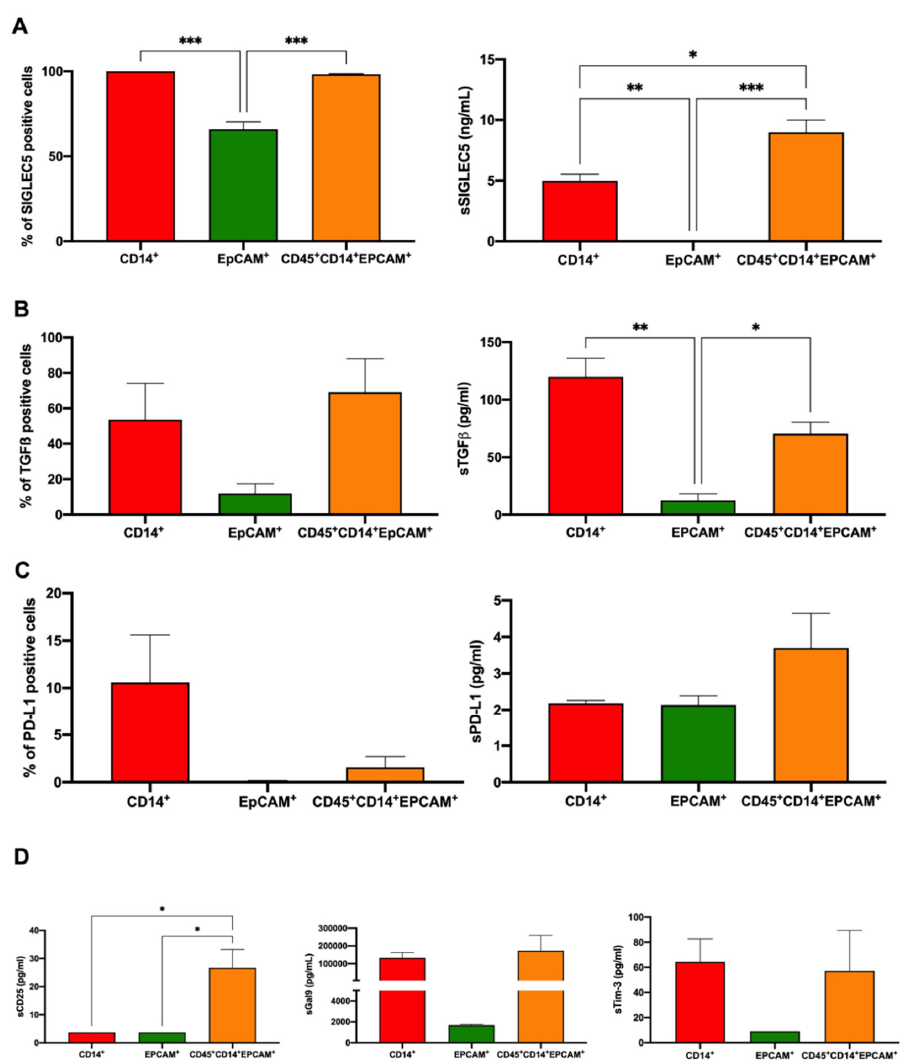
Figure 5. Characterisation of IC expression on THCs after co-culture. Left panels: expression of ( A ) SIGLEC5; ( B ) TGF β ; and ( C ) PD-L1 on the surface of human monocytes (red), SW620 CSC (green) and THCs (tangerine). Right panels: Soluble levels of A, sSIGLEC5 (ng/mL); B, sTGF β (pg/mL); and C, sPD-L1 (pg/mL) in the supernatant of sorted human monocytes (red), SW620 CSC (green) and THCs (tangerine) after a 5-day culture. ( D ) Soluble levels of sCD25 (pg/mL), sGal9 (pg/mL) and sTim3 (pg/mL) in the supernatant of sorted human monocytes (red), SW620 CSC (green) and THCs (tange- rine) after co-culture. n = 3; *, p < 0.05; **, p < 0.01; and ***, p < 0.001.